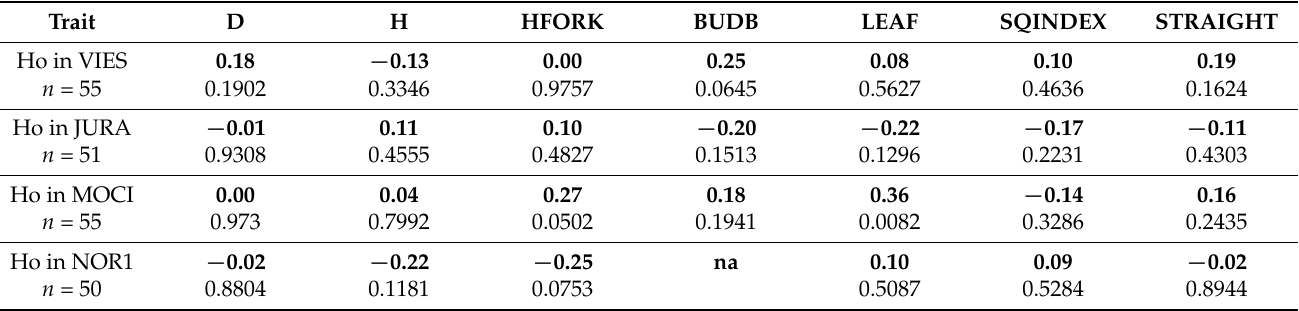
Table 4. Pearson product moment correlation coefficients (bold) and their significance between the wood yield, morphology traits and the observed heterozygosity calculated on individual tree level for each stand